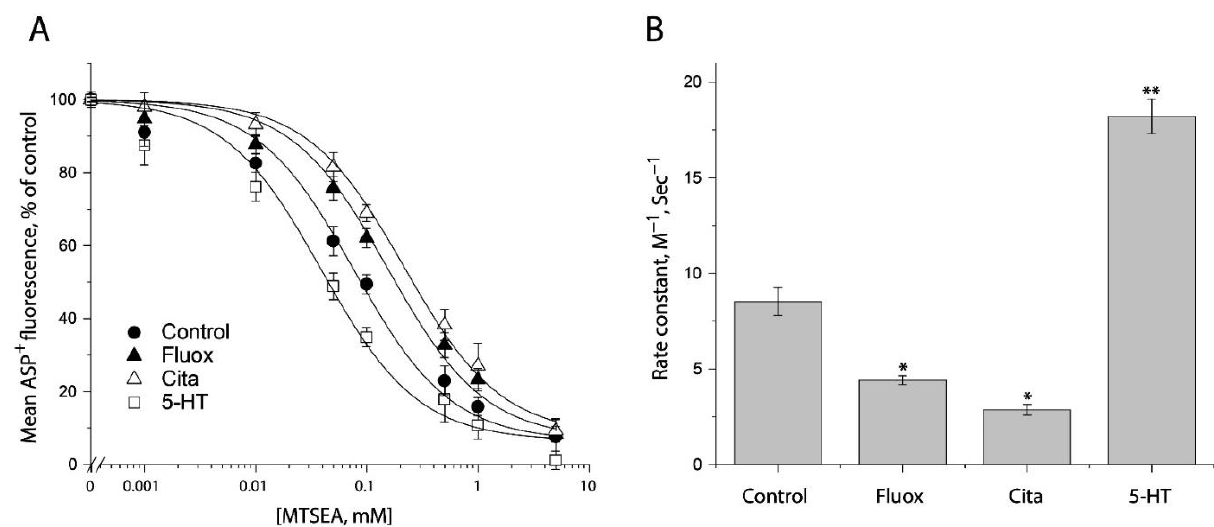
Figure 7. Ligand-induced accessibility changes in the cytoplasmic pathway. ( A ) The effects of ligands on MTSEA inhibition of ASP + binding of S277C/X5C. The cells stably expressing S277C/X5C were treated for 5 min with 25 µ g/mL digitonin and indicated concentrations of MTSEA in the absence or presence of 10 µ M fluoxetine (Fluox), citalopram (Cita) or 5-HT. After washing to remove excess MTSEA and ligands, ASP + binding was measured as described under “Materials and Methods”.